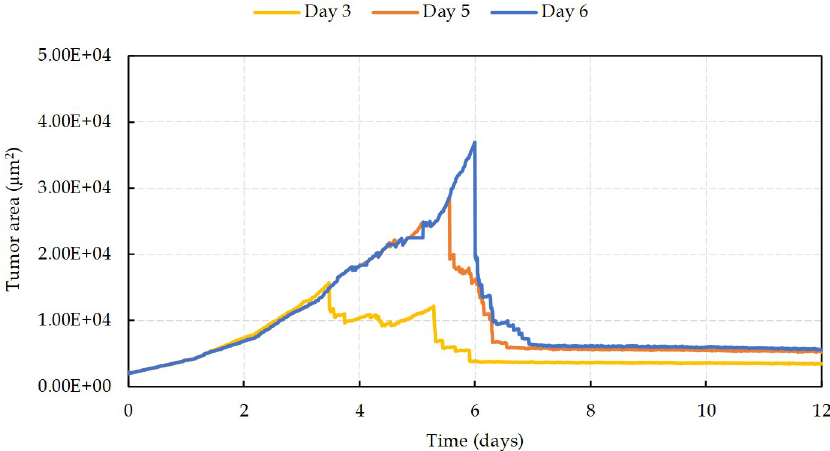
Fig 18. Tumor area evolution with therapy for various treatment initiation days. In all three cases there is a significant initial area decrease on the first day of therapy.